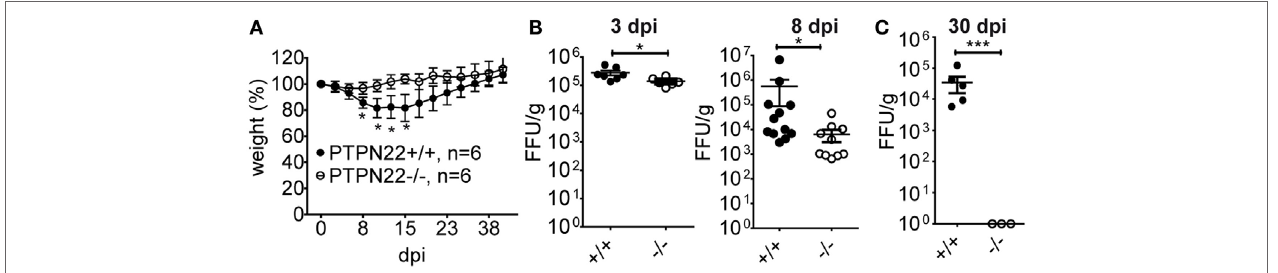
FigUre 1 | PTPN22 − / − mice show enhanced control of chronic lymphocytic choriomeningitis virus clone 13 (LCMV Cl13) infection. PTPN22 + / + (black circles) and PTPN22 − / − (white circles) mice were infected with 2 × 10 6 PFU of LCMV Cl13 i.v. (a) Body weight was measured twice weekly and the degree of weight loss served as a marker of disease severity. (B,c) Spleens were harvested after 3, 8, and 30 days post infection (dpi), and viral loads were determined by focus assay (focus forming unit, FFU). Data in (a) are representative of three experiments with similar results. Data in (B,c) are pooled from two experiments with similar results. Number of symbols reflects number of mice per